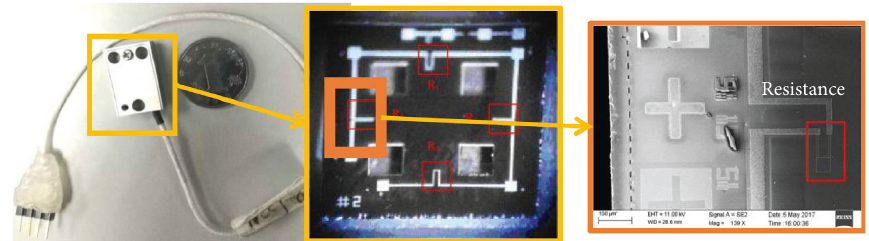
Figure 7: Overall photo, CCD photo, and SEM photo of the High-G MEMS